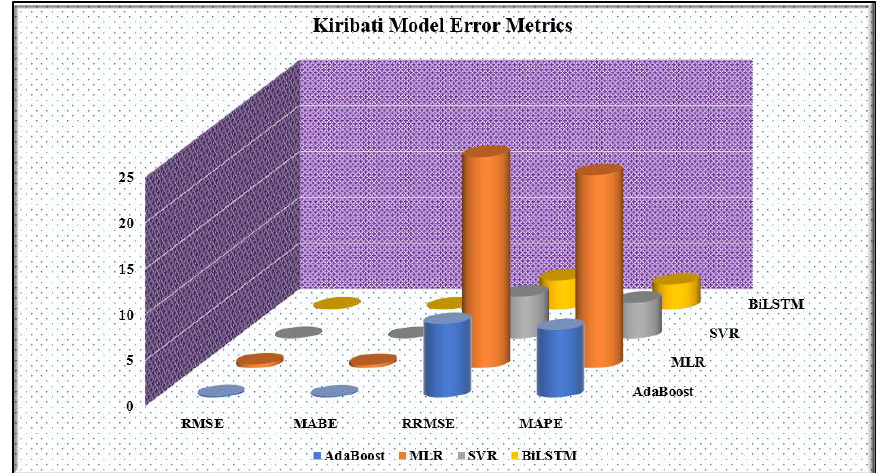
Figure 15. Bar chart of error metrics for Kiribati.